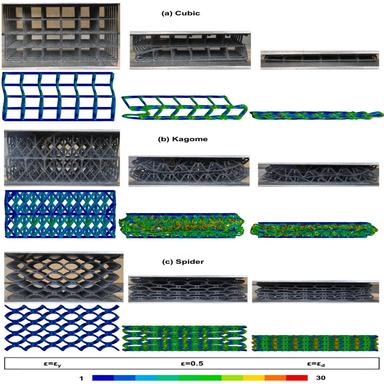
Comparison between the experimental and simulated bending of the struts at different strains (yield, 50%, and end of the plateau). The simulated figures show the effective stress developed in the struts of a) cubic, b) kagome, and c) spider lattice structures (set 1).